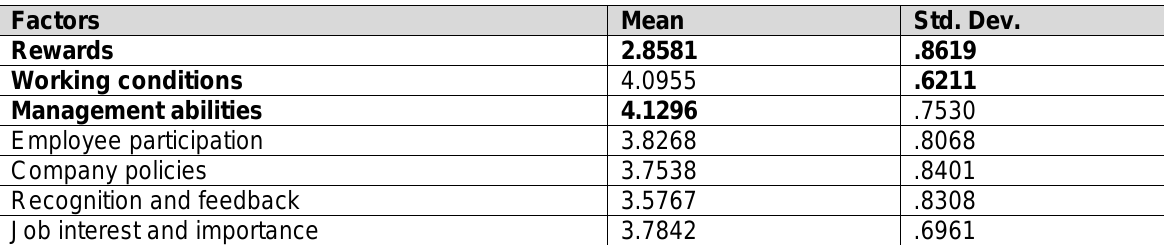
Table 4: Motivational factors – Mean and standard deviation scores Factors